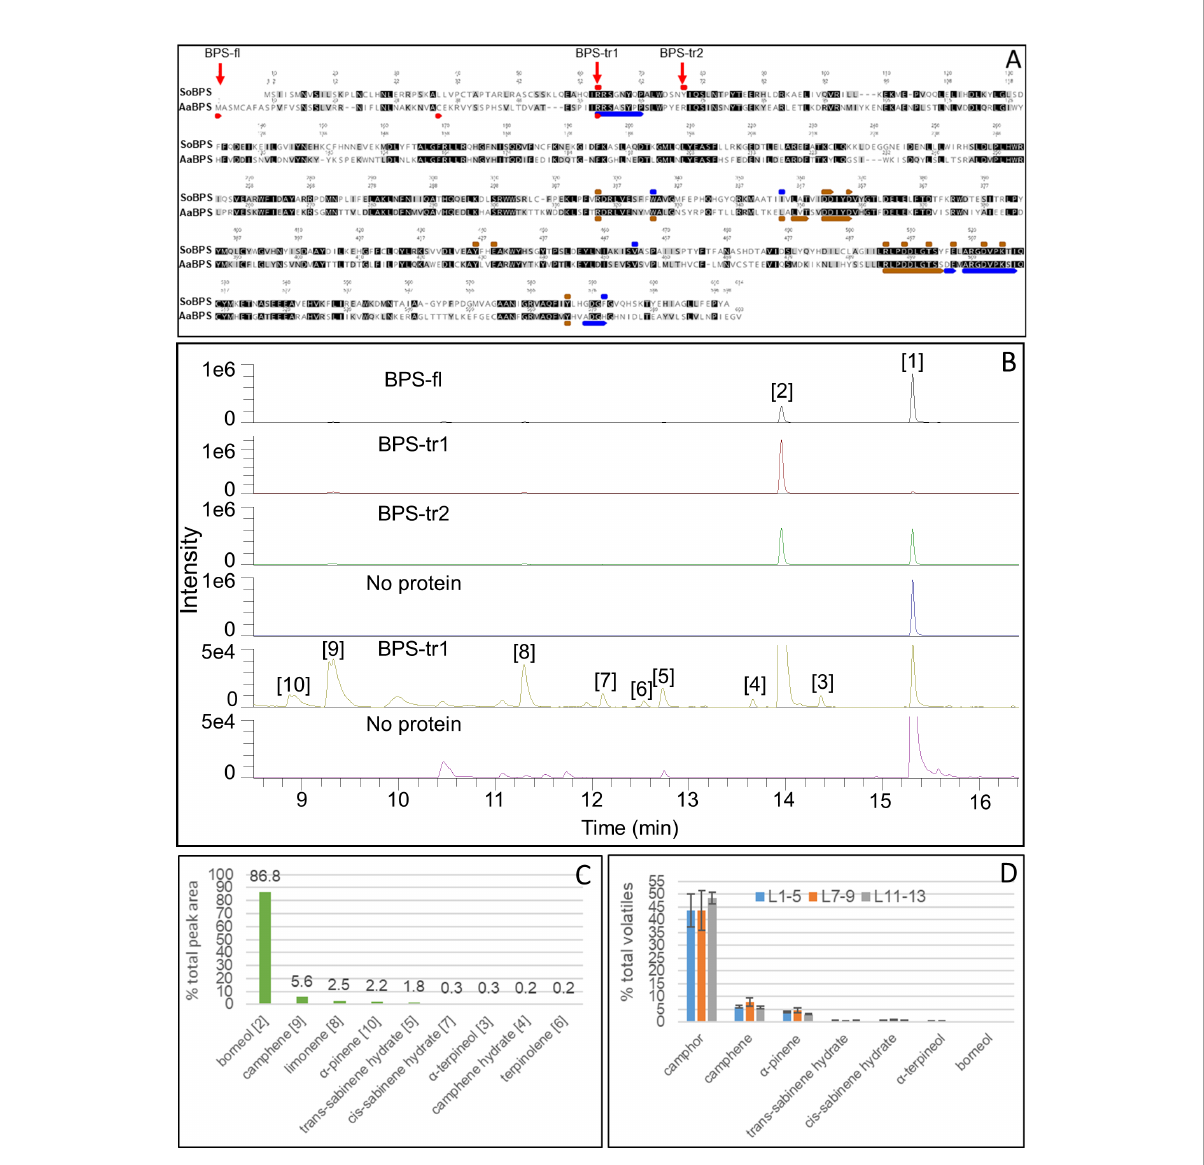
FIGURE 6 Functional characterisation of AaBPS . (A) Alignment of predicted amino acid sequence of AaBPS (GenBank accession OL656813) with SoBPS (GenBank accession AF051900). Truncation points used to generate truncated versions of AaBPS are indicated as BPS-tr1 and BPS-tr2. BPS- fl represents a full length protein. Red bars – active site lid, Blue bars - active site, Brown bar – substrate binding site annotated from Whittington et al., 2002. Identical (Black) and similar (grey) positions highlighted. (B) AaBPS in vitro protein activity assay using gas chromatography – mass spectrometry (GC-MS) based detection of monoterpenes. No protein control includes geraniol, the product of GPP hydrolysis (peak 1). Identi fi cation of peak 1 and 2 as geraniol and borneol respectively was assigned using known standards. Identities of peaks 3-10 were assigned using the NIST database and shown in (C). (C) Relative abundance of AaBPS in-vitro products for the most active truncated version of the protein (BPS-tr1). (D) Relative abundance of selected volatiles in three types of A annua Artemis leaves measured by GC-MS: L1-5 (juvenile), L7-9 (expanding), L11-13 (mature). Error bars – SE